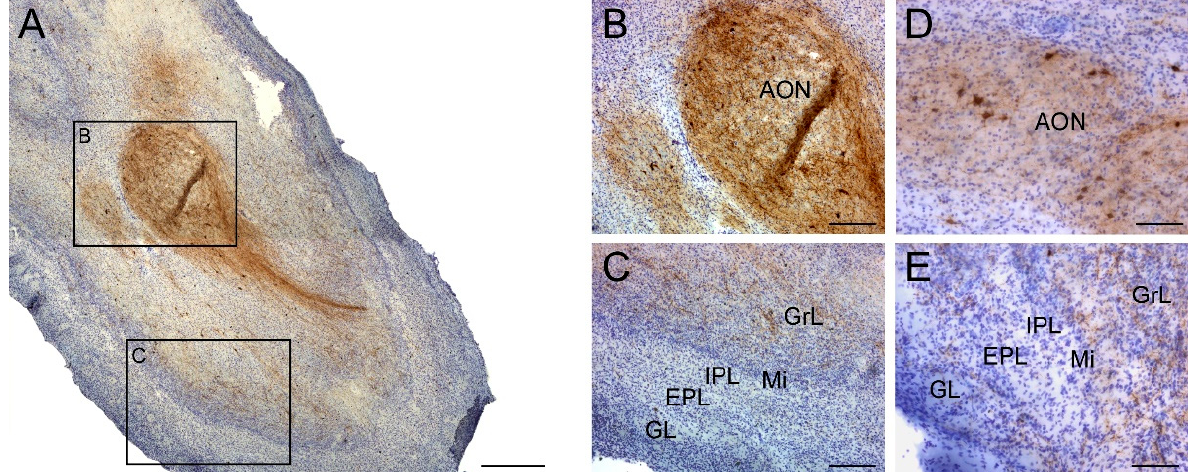
Figure 1. Immunohistochemistry staining for somatostatin in the olfactory bulb. Somatostatin is present in all regions within the olfactory bulb ( A ) with a striking presence in the anterior olfactory nucleus ( B ), and expression was low in the GrL and within the Mi, IPL, EPL and GL external layers in non-AD cases ( C ). Similarly, SST-cells did not show neurodegeneration features in AD cases and were mainly placed in the anterior olfactory nucleus ( D ). In addition, lower intensity of labeling in SST -expressing fibers was observable in the rest of olfactory layers in AD cases ( E ). Note that the number of somatostatin-expressing cells was very low compared with the number of somatostatin fibers. GrL; granule cell layer, Mi; mitral cell layer, IPL; internal plexiform layer, EPL; external plexiform layer, GL; glomerular layer. Scale bar A , 500 µm; B , C , 200 µm.